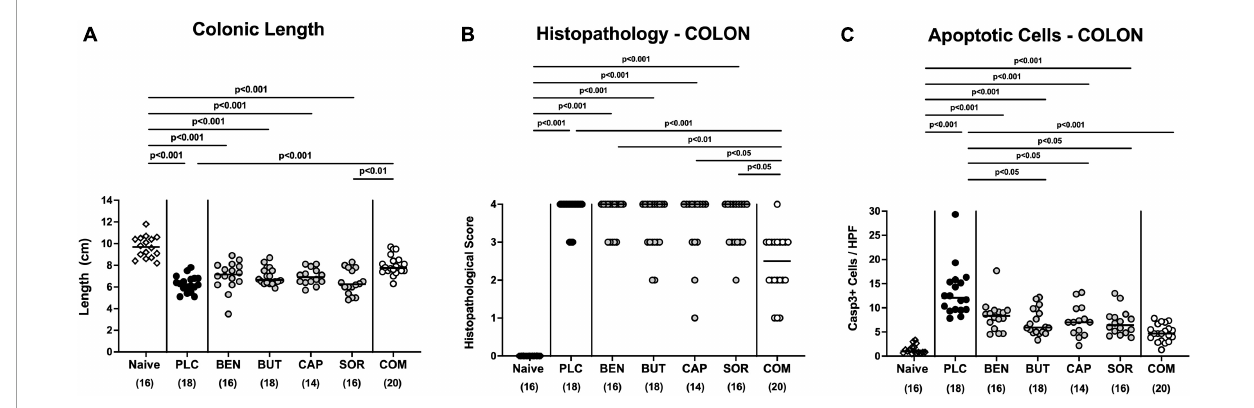
FIGURE4 Macroscopic and microscopic inflammatory responses in the colon following single and combined organic acid treatment. C. jejuni infected mice were treated with benzoic acid (BEN), butyric acid (BUT), caprylic acid (CAP), sorbic acid (SOR), a combination of all acids (COM) or received placebo (PLC). On day 6 post-infection, (A) the colonic lengths were measured and (B) the histopathological changes in hematoxylin and eosin-stained ex vivo colonic biopsies were quantified by standardized histopathology scores. (C) Furthermore, the average numbers of apoptotic colonic epithelial cells (positive for caspase3, Casp3+) were determined microscopically from six high power fields (HPF, 400 × magnification) per mouse applying in situ immunohistochemical analysis of large intestinal paraffin sections. Naive mice were used as negative controls. Medians (black bars), significance levels ( p values) calculated by the ANOVA test with Tukey’s post-correction or by the Kruskal–Wallis test and Dunn’s post-correction, and the total mice numbers (in parentheses) are given. Data were pooled from three independent experiments.